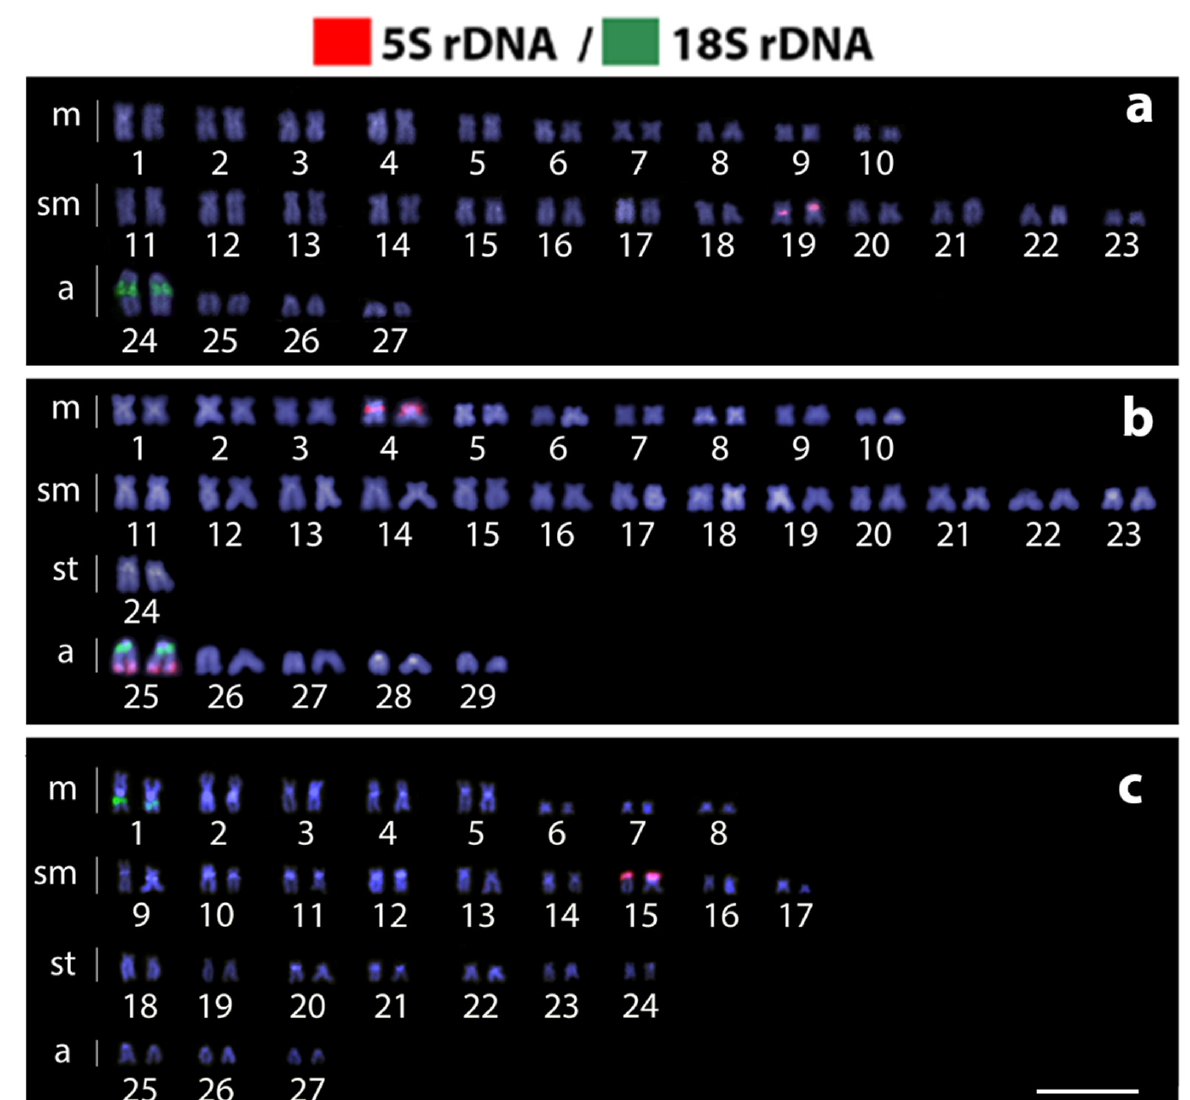
Figure 3. Karyotypes of Harttia dissidens ( a ), H. guianensis ( b ), and Harttia sp. 3 ( c ) after dual-color FISH: 5S (red signals) and 18S (green signals) rDNA. Note the adjacent position of 5S and 18S rDNA signals on chromosome pair No. 25 in H. guianensis ( b ). Chromosomes were counterstained with DAPI (blue). Scale bar = 10 µm. The mapping of three microsatellite sequences revealed a similar pattern for (CA) 15 and (GA) 15 , with accumulation at the terminal regions of all chromosomes. The last studied motif, (A) 30 , presented a dispersed distribution throughout the chromosome complement of H. dissidens and H. guianensis , while it was accumulated in the pericentromeric regions of few chromosome pairs in Harttia sp. 3 (Figure 4). The mapping of the telomeric (TTAGGG) n sequence revealed only the standard pattern in all the three species, i.e., positive signals at the physical ends of all chromosomes (Figure